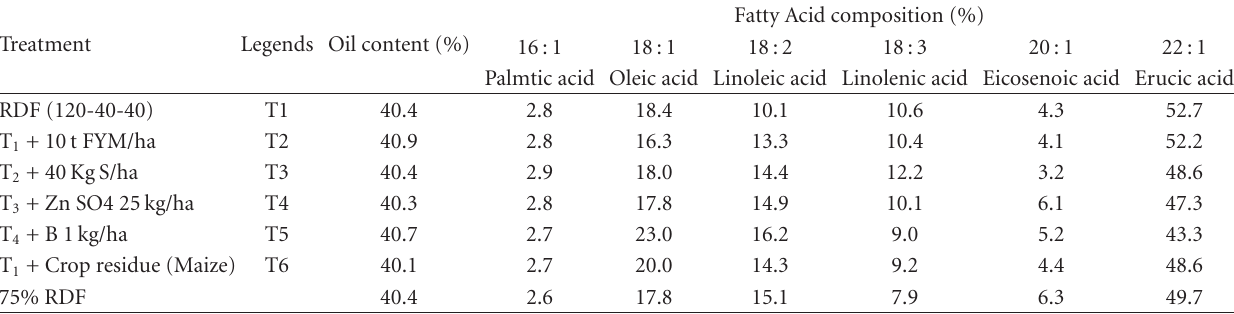
Table 9: E ff ect of INM on quality of mustard (Kanti-RK 9807) under maize-mustard sequence.